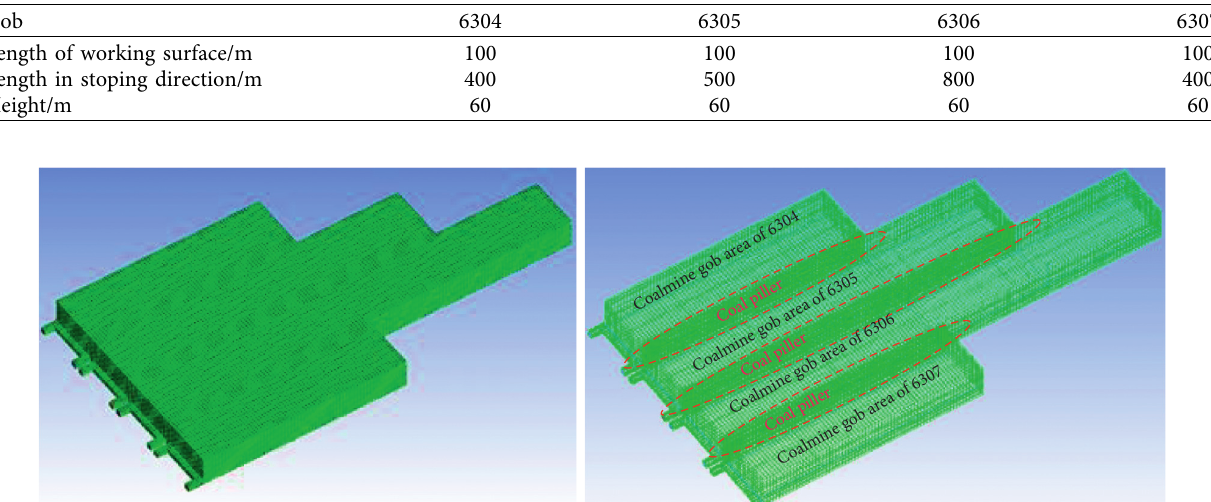
Figure 9: Mesh division of